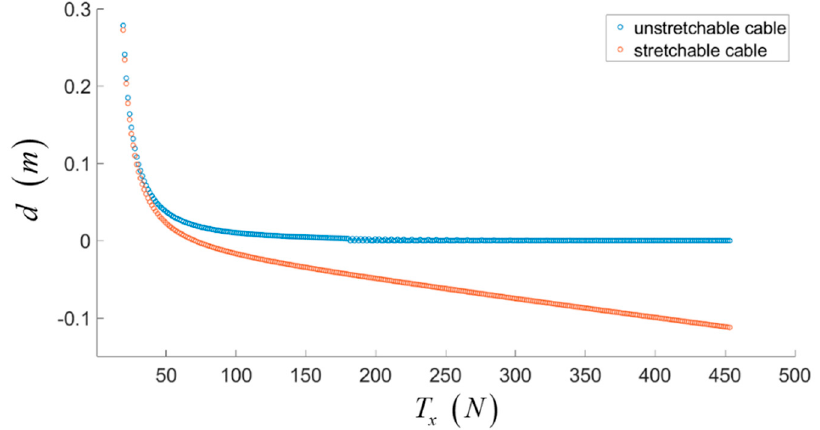
Figure8. Therelationshipbetweendand T x Figure 8. The relationship between d and instance.